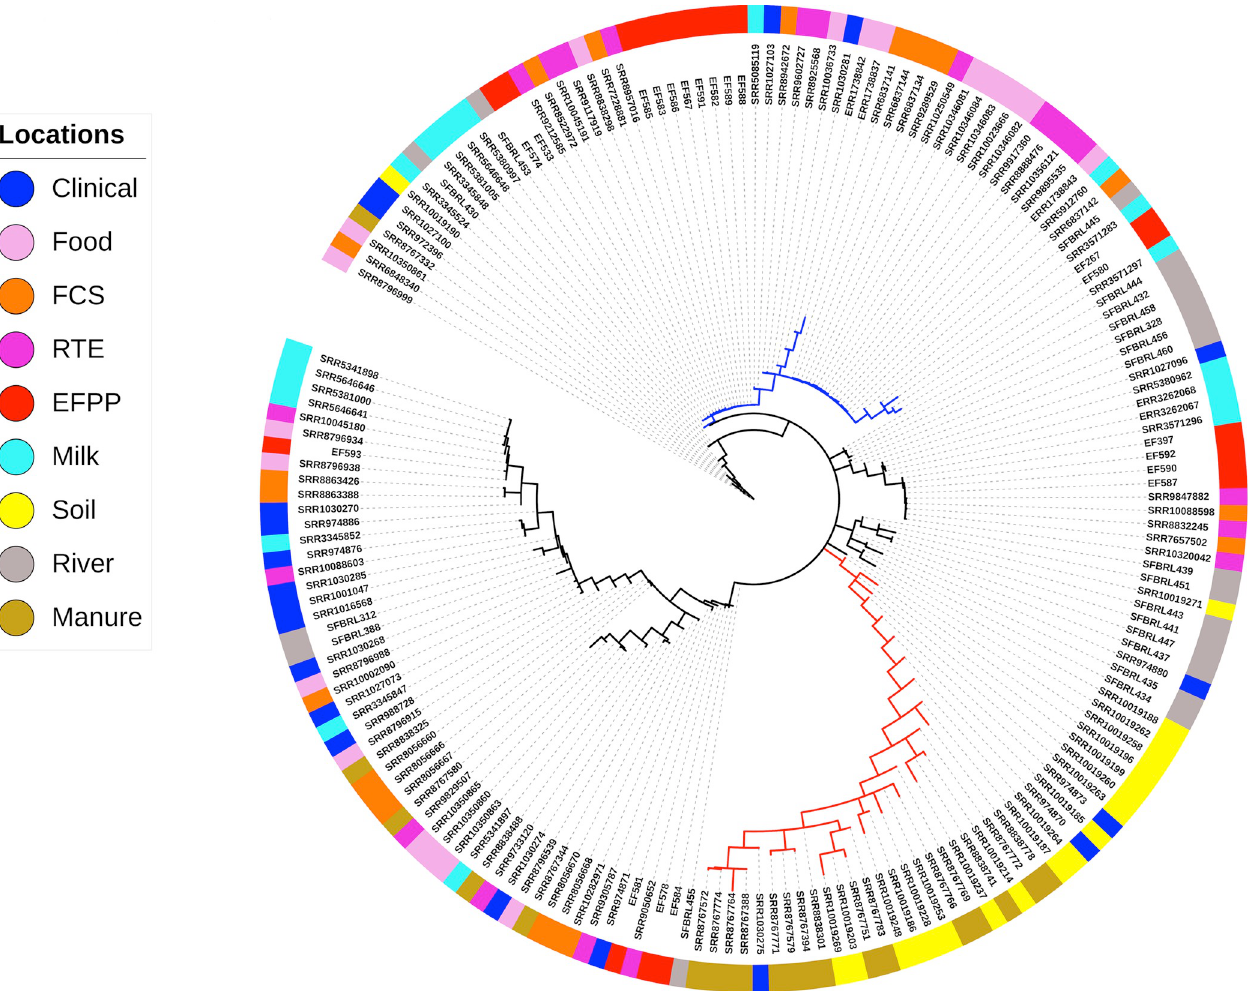
Fig 1. Patterns of genetic differentiation in the 180 L . monocytogenes isolates. Minimum spanning tree based on a distance matrix measuring pairwise differences in allelic content between isolate wgMLST profiles. The isolation source of each isolate is indicated with colors on the outer ring. Majority of the isolates sampled from soil and manure cluster together in a distant branch (red), suggesting their recent emergence from a common ancestor. A large number of food-related isolates cluster together in a single branch of the tree (blue), suggesting their close relatedness.